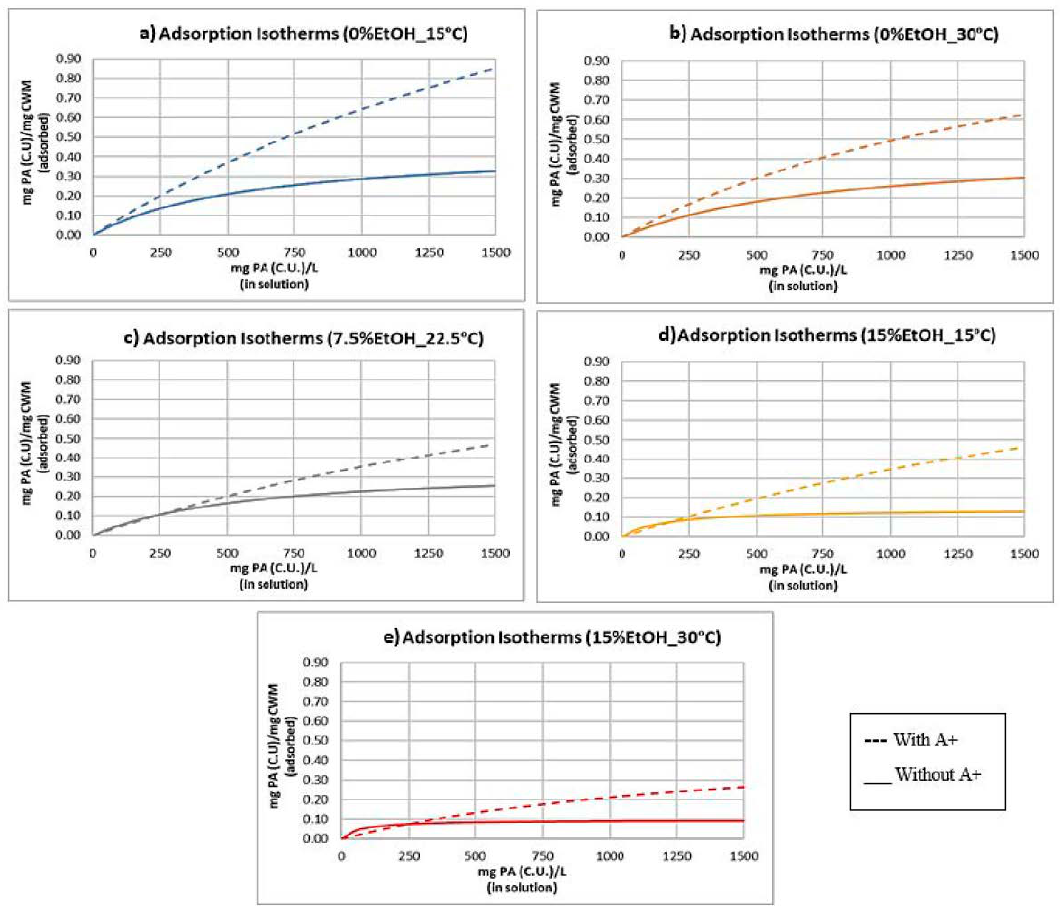
Figure 7. Adsorption isotherm of all conditions with Langmuir models applied ( n = 9 for each isotherm). All “Without A + ” isotherms were derived from a previous study [7]. ( a ) 0% ethanol MW, 15 ◦ C incubation; ( b ) 0% ethanol MW, 30 ◦ C incubation; ( c ) 7.5% ethanol MW, 22.5 ◦ C incubation; ( d ) 15% ethanol MW, 15 ◦ C incubation; ( e ) 15% ethanol MW, 30 ◦ C incubation. “A + ” = anthocyanins.